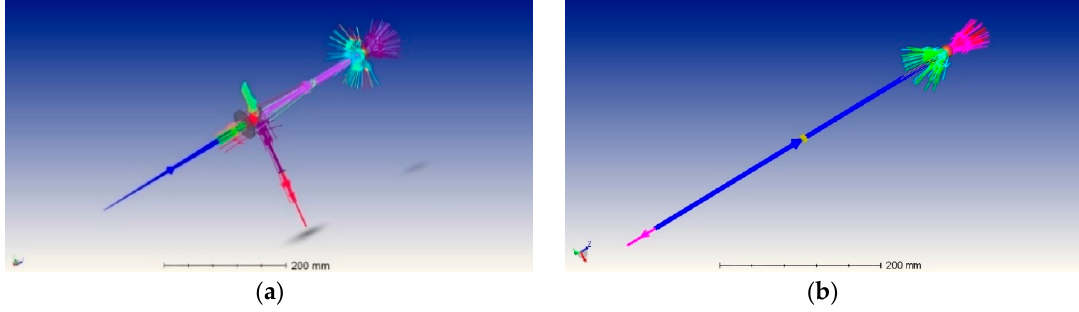
Figure 18. Two equivalent set ups simulated with Zemax. ( a ) Complete layout with all optical components; ( b ) Functionally equivalent simplified layout (to improve the simulation speed).